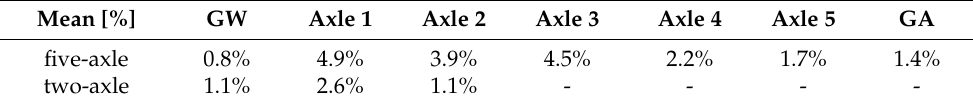
Figure 23. Example of a run with a change of trajectory.